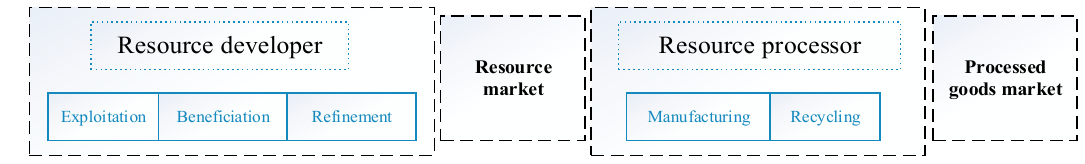
Figure 1. A genetic two-stage resource-based supply chain.